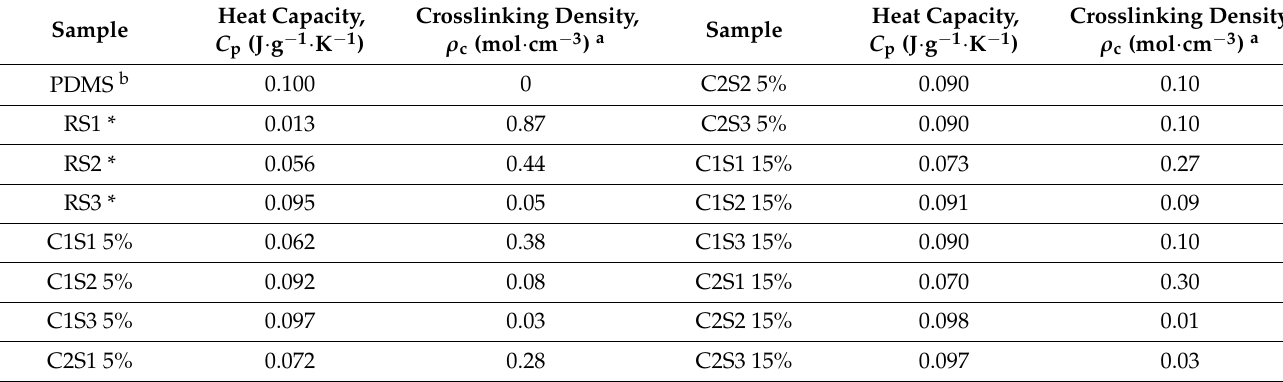
Table 3. Calculation of crosslinking degree from DSC